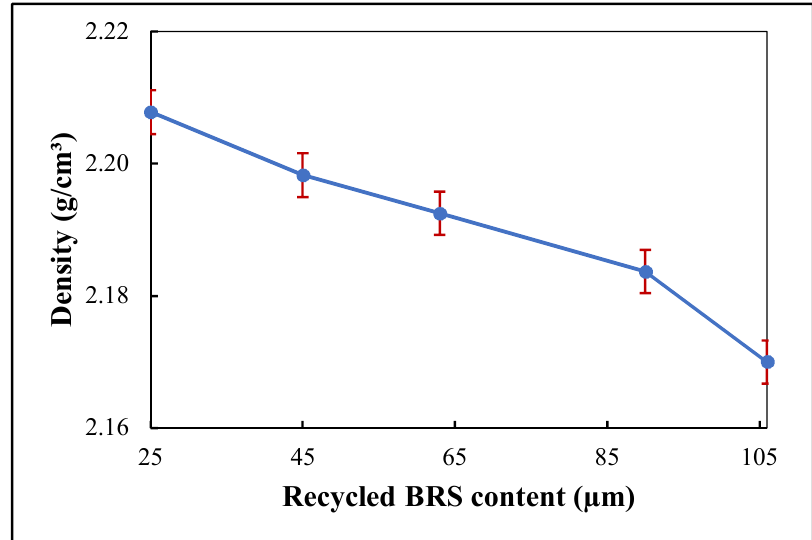
Figure 5. Variation of moisture absorption with filler size.